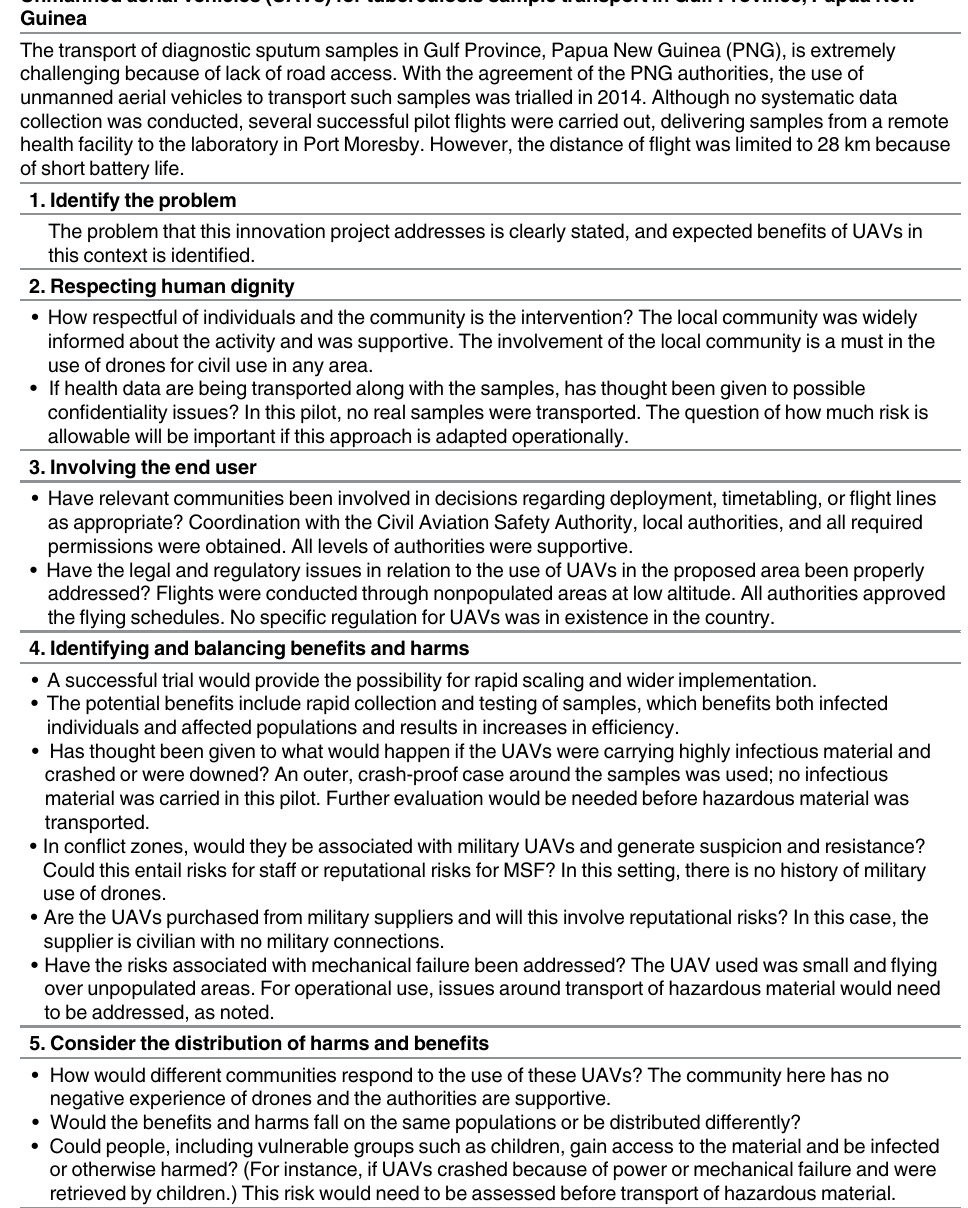
Table 1. New technology for an old disease: unmanned aerial vehicles for tuberculosis sample trans- port in Papua New Guinea